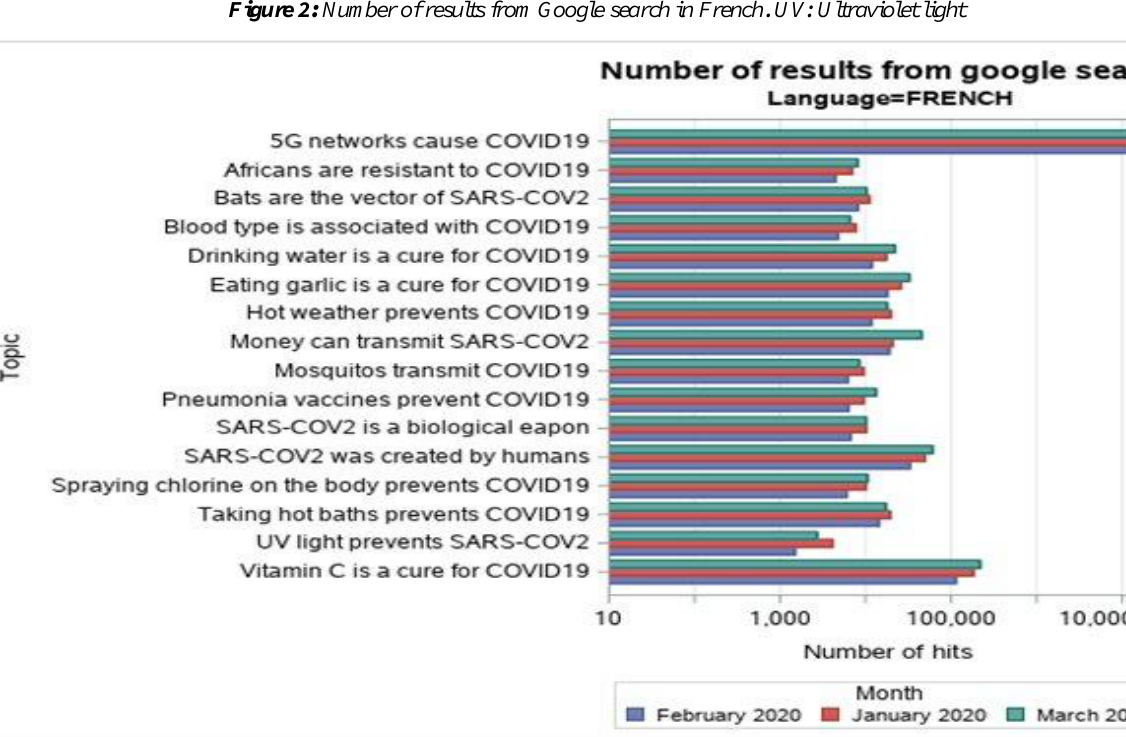
Figure 3: Number of results from Google search in Spanish. UV: Ultraviolet